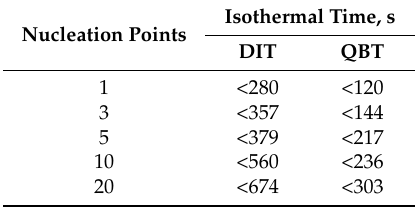
Table 1. Relationship between the number of bainitic-ferrite nucleation points and the isothermal